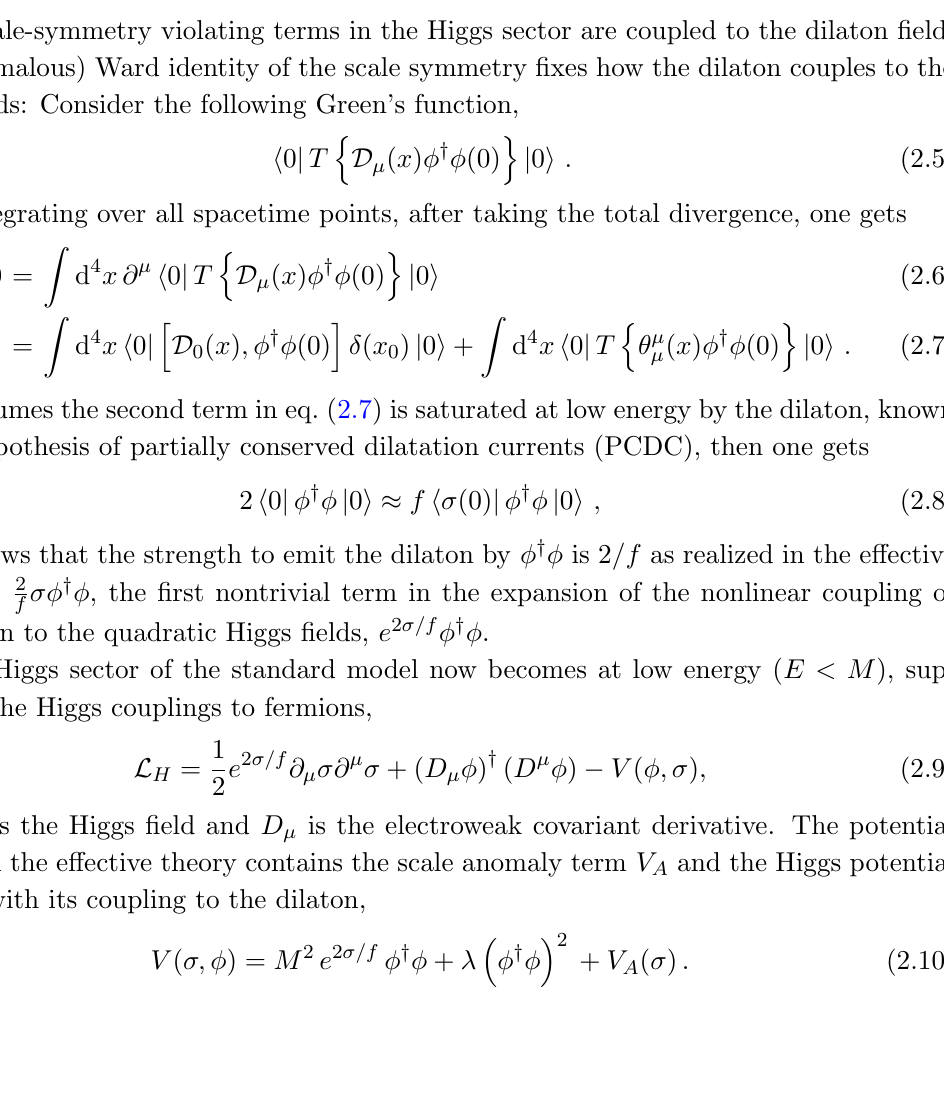
Figure 1 . (a) A scale-invariant UV theory of the SM Higgs sector above M scale symmetry is spontaneously broken at (cid:3) SB the dilaton, in addition to the SM particles. (b) The behavior of couplings in the UV theory as a function of scale, E